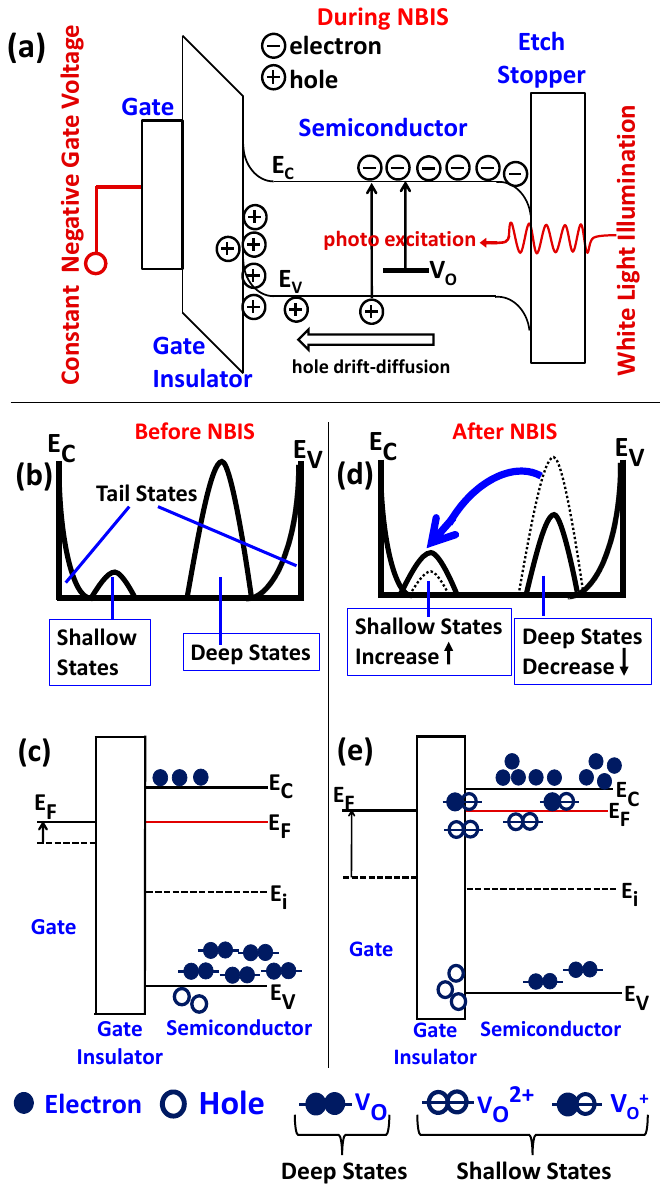
Figure 8. Effect of negative-gate bias stress combined with visible light illumination (NBIS). ( a – e ) Thin-film transistor (TFT) current-voltage ( I - V ) characteristics before and after NBIS for varying amorphous indium-gallium zinc-oxide thickness ( t IGZO ). Turn-on voltage ( V ON ) dependence on NBIS Time. Channel width W = 2000 µm and channel length L = 10 µm. The NBIS-induced negative turn-on voltage ( V ON ) shift increases with increasing t IGZO . NBIS is accomplished by holding the TFT gate voltage at − 20 V for 10,000 s, while biasing the source and drain electrodes at zero volts, under white light illumination (9000 nit).